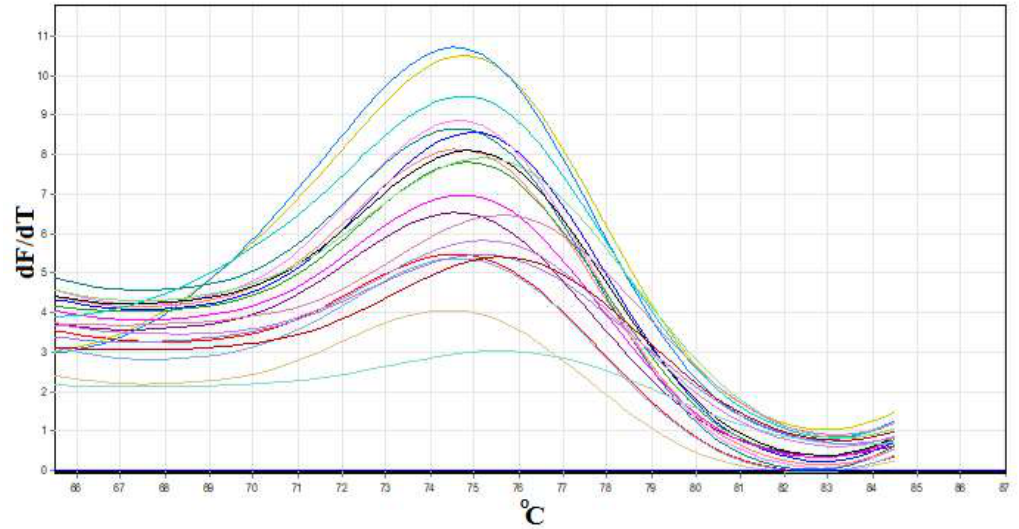
Figure 3: Melt curve of 122a gene after RT-qPCR analysis showing single peaks for different